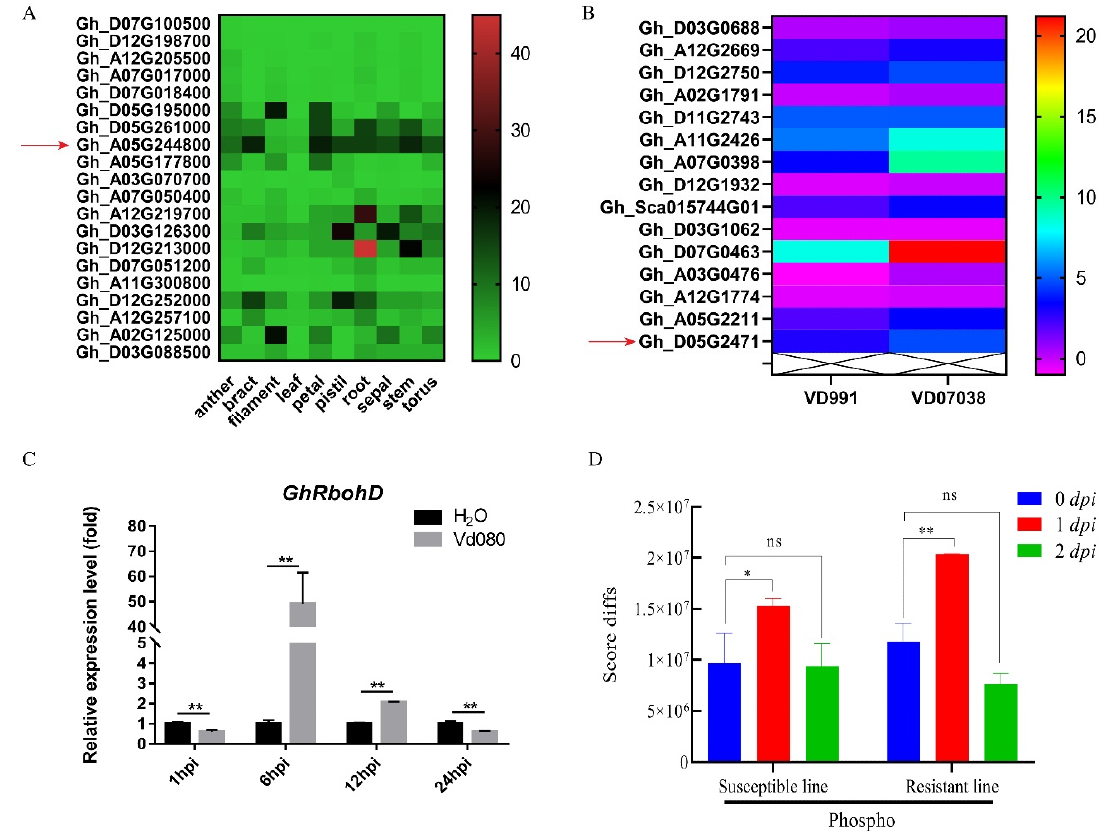
Figure 2. The expression of GhRbohD in cotton under different conditions. ( A ) Transcriptional level analysis of GhRbohD family genes in various tissues of Upland cotton YZ-1. ( B ) The transcription levels of GhRboh family genes in G. hirsutum under strong pathogenicity (VD991) and moderate pathogenicity (VD07038) stress. ( C ) The expression level of GhRbohD in Zhongzhimian 2 under pathogen stress. ( D ) Analysis of the levels of phosphorylation modification of proteins after translation at different times RIL-R and RIL-S varieties under pathogenic stress [24]. Asterisks indicate statistically significant differences, as determined by Student’s t -test (* p < 0.05; ** p < 0.01). ns represents no significant